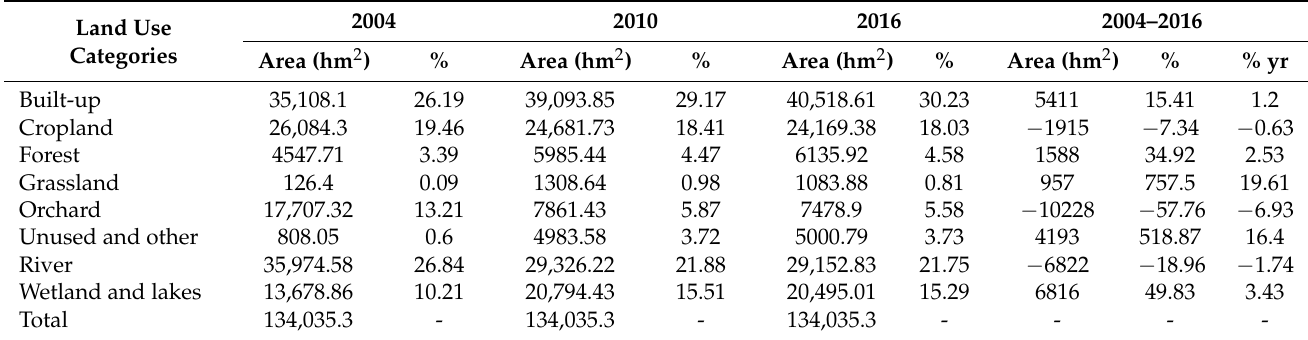
Table 4. Land use changes in the study area.